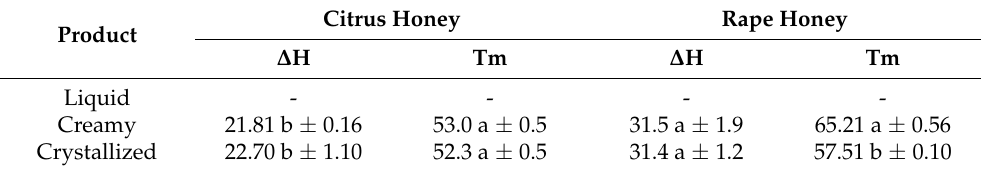
Table 2. Melting enthalpy ( ∆ H, J/g) and temperature (Tm, ◦ C) as obtained by differential scanning calorimetry ( ± SEM). Values with different letters correspond to statistical differences (Tukey’s HSD test).